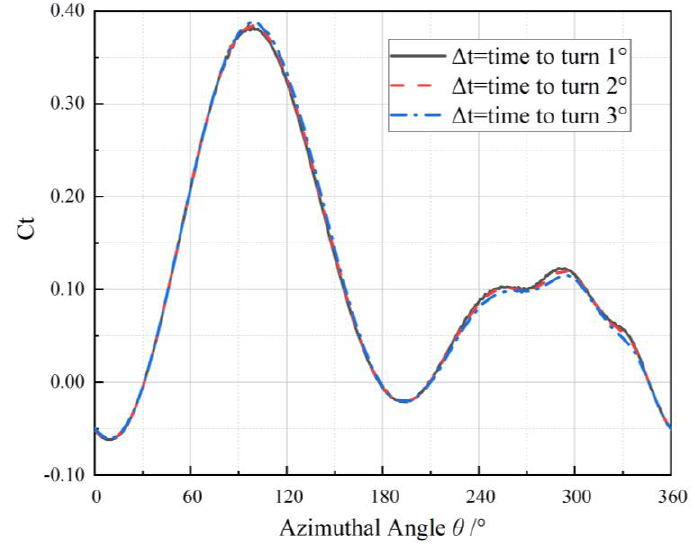
Figure 6. Instantaneous torque of a blade under three time-step sets.